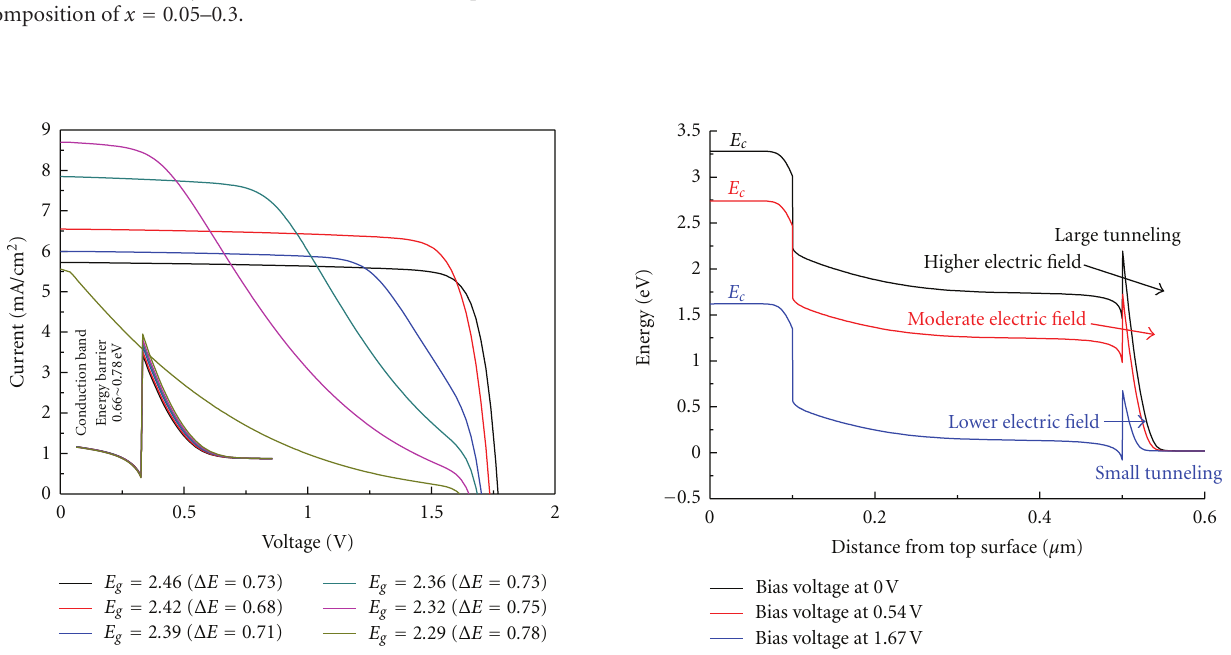
0.26, which is corresponding to an energy barrier of 0.68 eV.